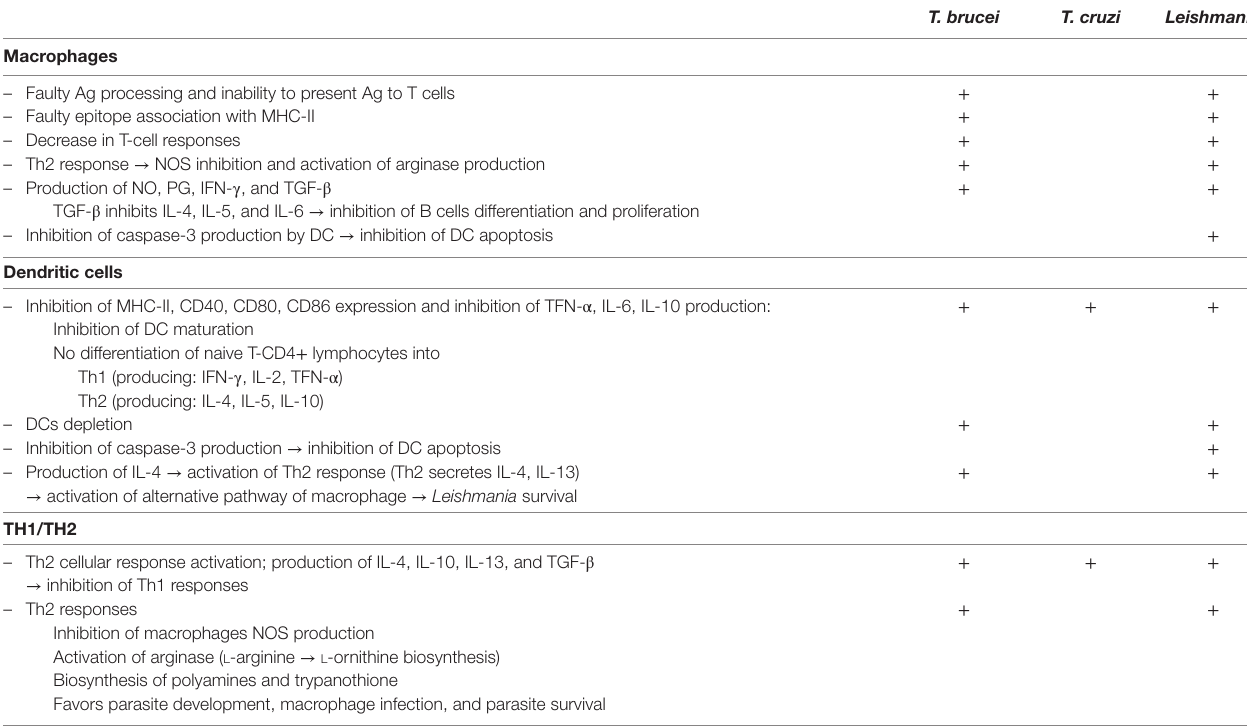
TABLe 2 | effects of either Trypanosoma brucei sp. , Trypanosoma cruzi or Leishmania sp on host immune responsive cells [for T. brucei : Dagenais et al. (121); vincendeau and Bouteille (122); for T. cruzi : Chaussabel et al. (84); Flávia Nardy et al. (123); for Leishmania : Bogdan et al.